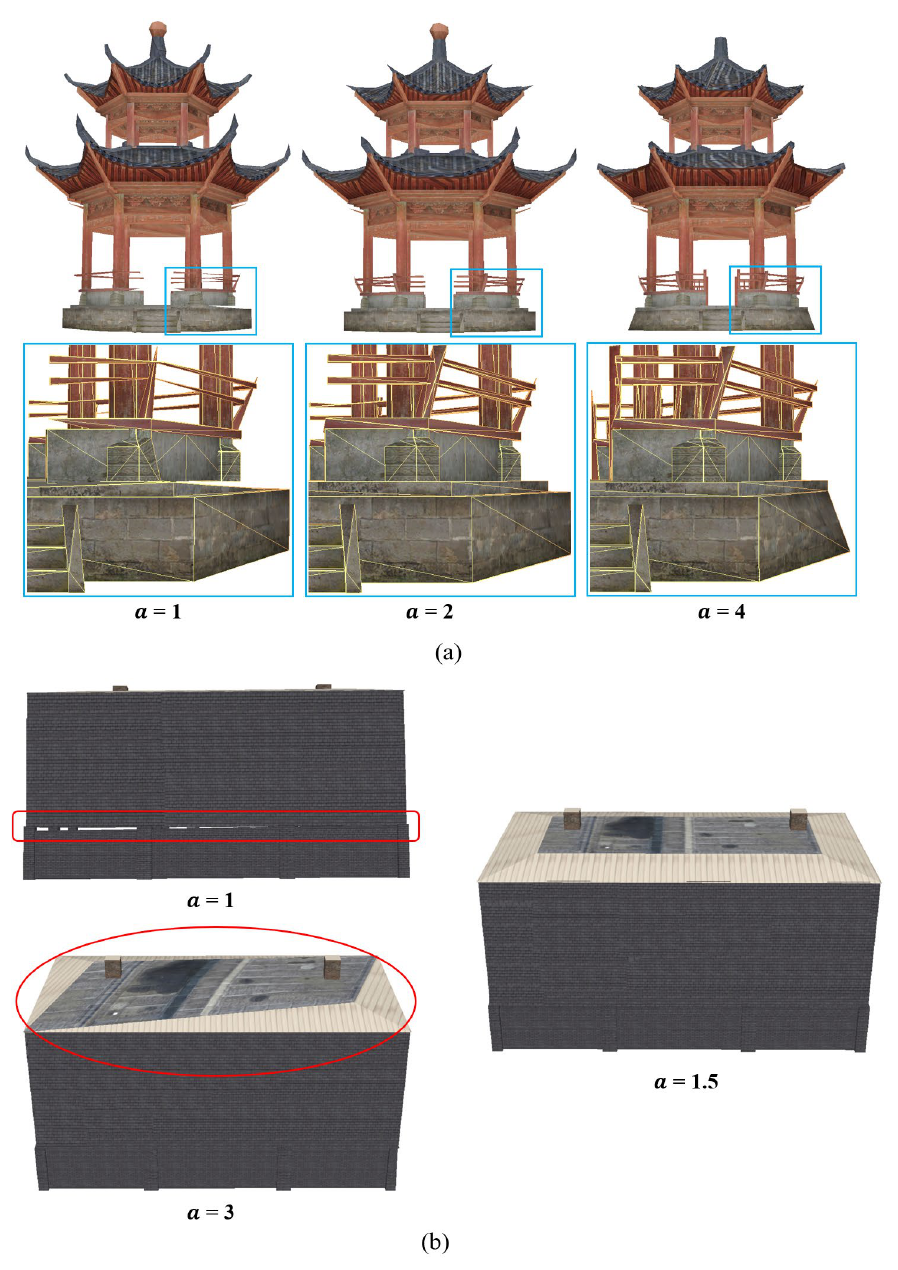
Figure 16. Experiences of parameter analysis: ( a ) complex building (pavilion); ( b ) simple building (apartment).